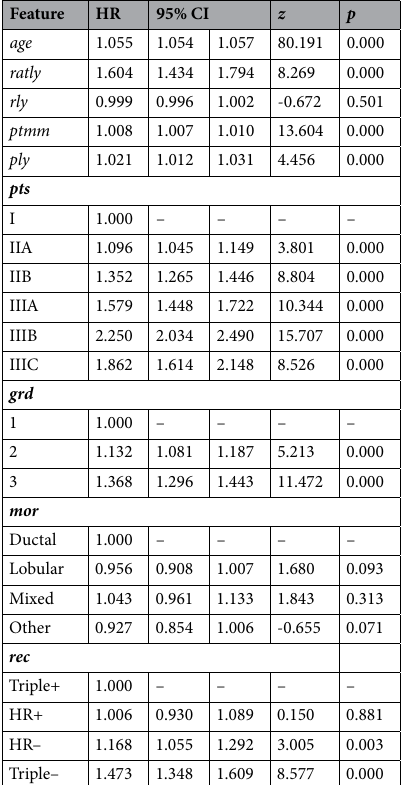
Table 3. Results of the CPH model. HR hazard ration, CI confidence interval, HR + hormone receptor positive, HR - hormone receptor negative.